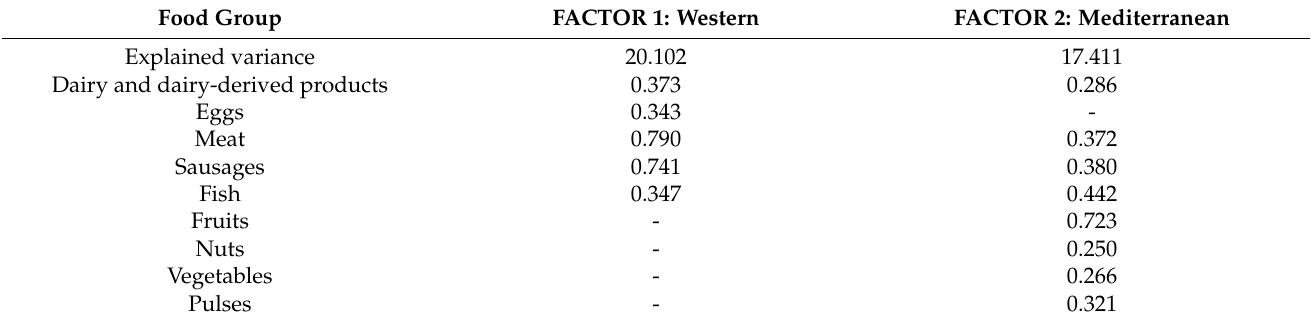
Table 3. Eating patterns obtained on the basis of food groups related to daily consumption. Food